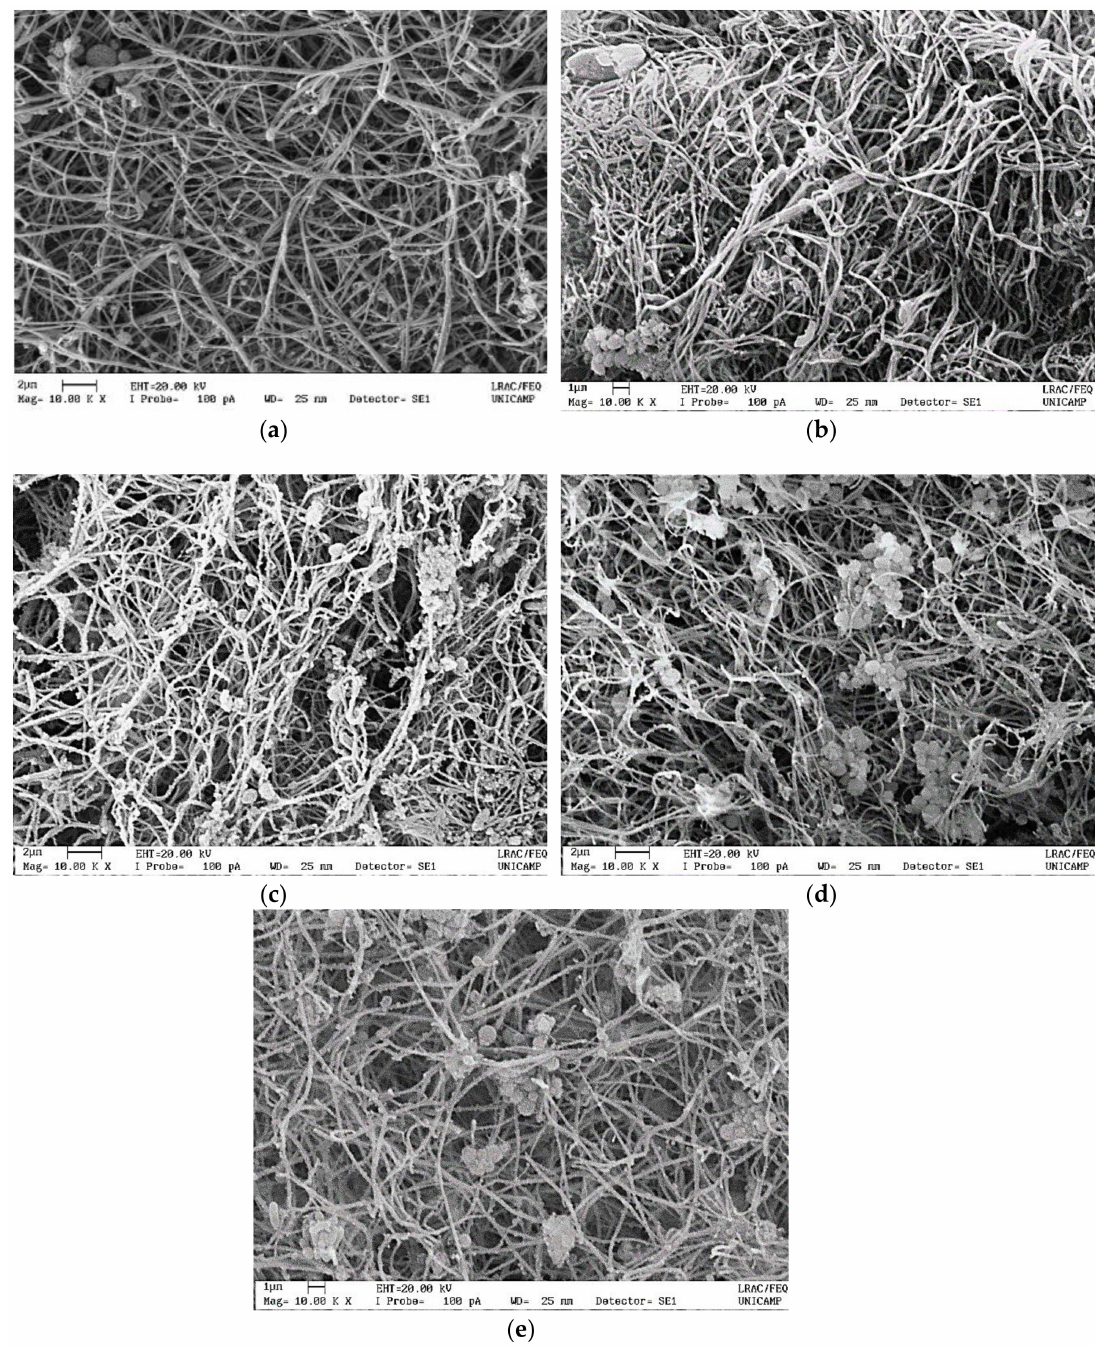
Figure 6. Scanning electron microscopic micrographs of ( a ) A P-PRP, ( b ) A P-PRP / A P-PRP / MP AHA, ( c ) A P-PRP / MP AHA-CHT 90:10 , ( d ) A P-PRP / MP AHA-CHT 75:25 , and ( e ) A P-PRP / MP AHA-CHT 50:50 after four days of cultivation of